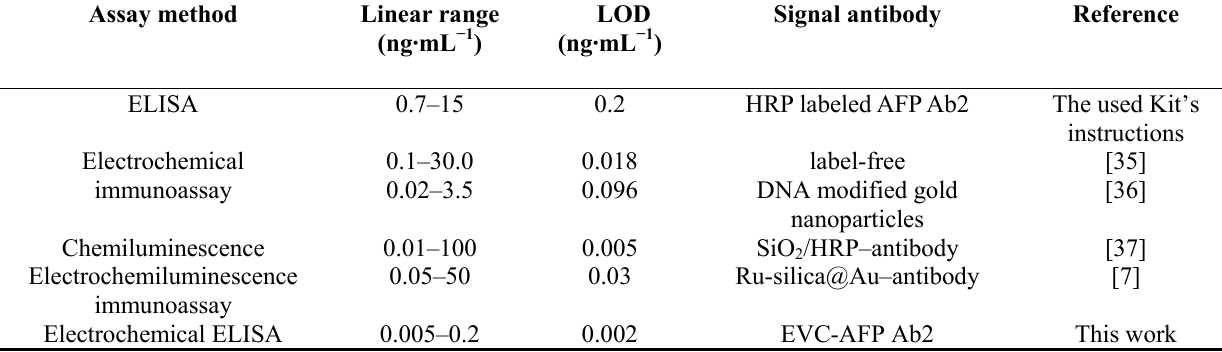
Table 1. Comparison of analytical properties of various AFP immunosensors or immunoassays. Assay method